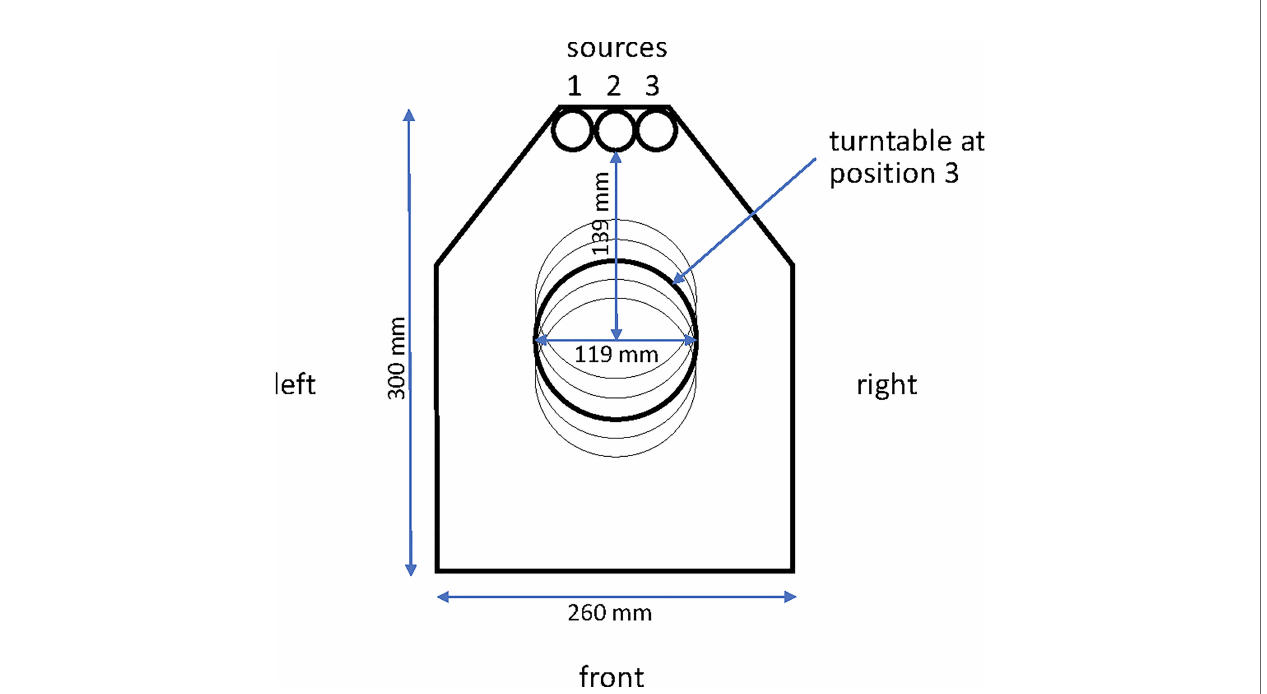
FIGURE 1 | Plan view of the interior of the irradiator chamber. The three source tunnels (left #1, center #2 and right #3) are indicated at the apex of the drawing and the turntable is indicated at position 3 (of 5 potential positions) in the central axis of the